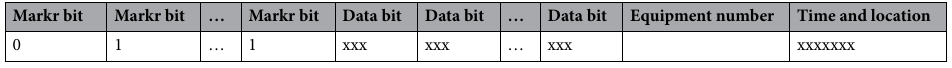
Table 3. The specific meaning of each position of the received data.